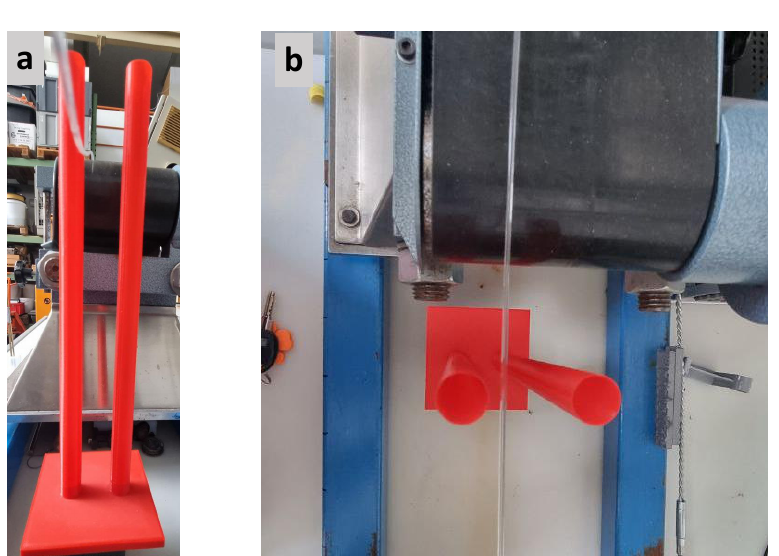
Figure 13. Three dimensional (3D) printed device to keep the filament coming from water bath on to the conveyor belt. ( a ) front-view of the 3D printed structure to keep the filament from slipping off of the conveyor belt, ( b ) top-view of the 3D printed